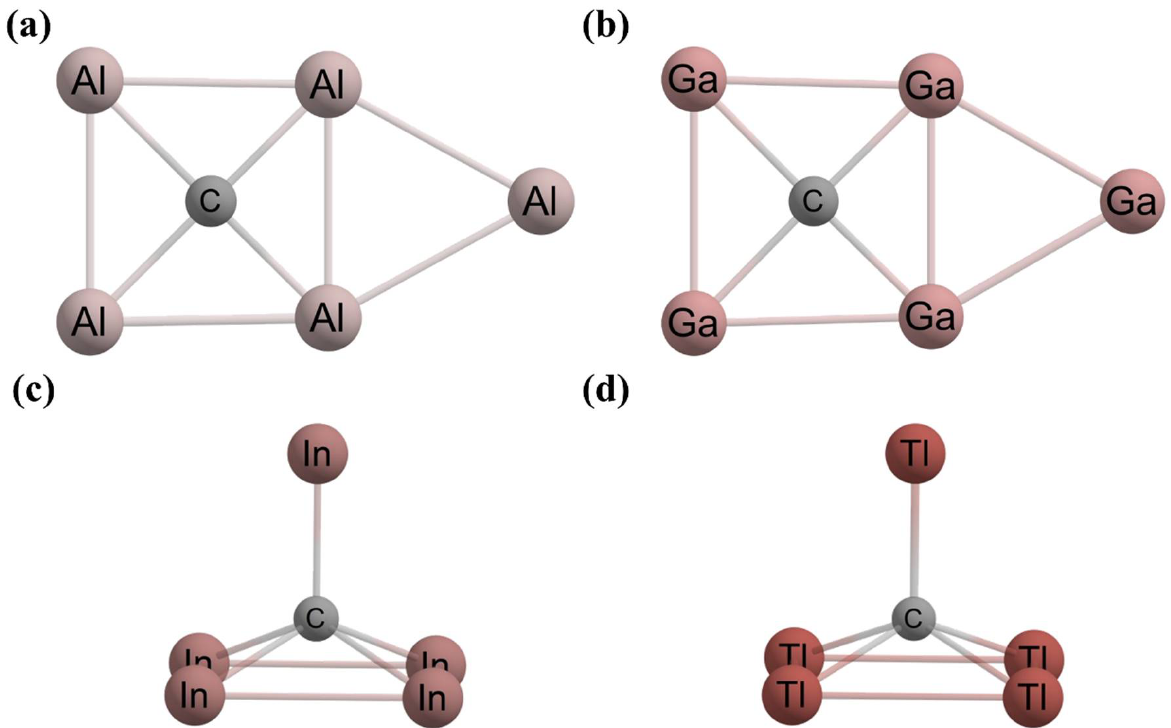
Figure 11. The global minimum structures of ( a ) CAl 5− , ( b ) CGa 5− , ( c ) CIn 5− , and ( d ) CTl 5− clusters. Another 12-valence electronic system, CBe 3 X 3+ (X = H, Li, Na, Cu, Ag) (Figure 12), was predicted by Guo et al. in 2019 [93]. The PES search shows that the ptC structures are global minima, in which the central carbon is connected to three in-plane beryllium (Be) atoms and a terminal X center. The remaining two X atoms are present at the perimeter and each bridge with two beryllium atoms. The second most stable geometries for CBe 3 X 3+ (X = H, Li, Na, Cu, Ag) have 3.66, 3.98, 1.90, 7.91, and 5.92 kcal mol − 1 higher energies